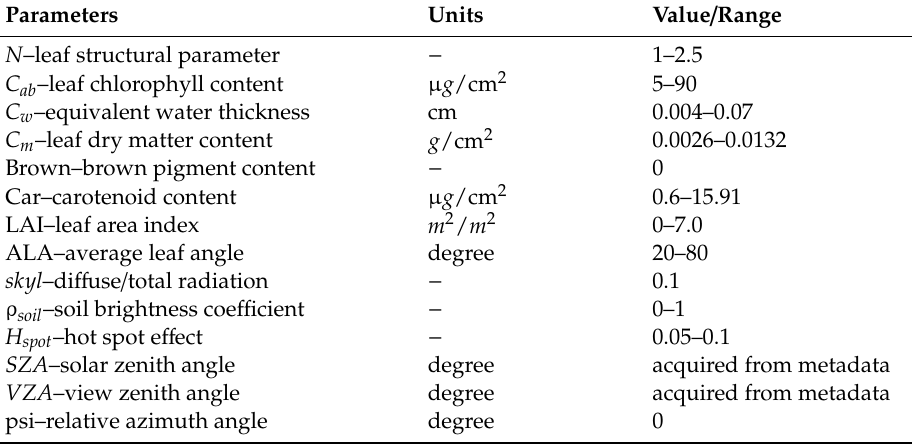
Table 2. List of canopy and leaf parameters applied in PROSAIL radiative transfer modelling (RTM) for modeling canopy surface